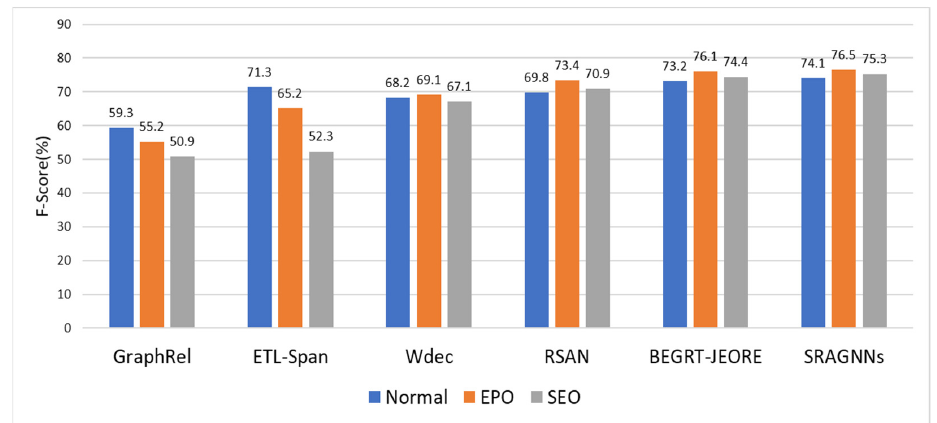
Figure 3. Results on different sentence types according to the degree of overlapping.